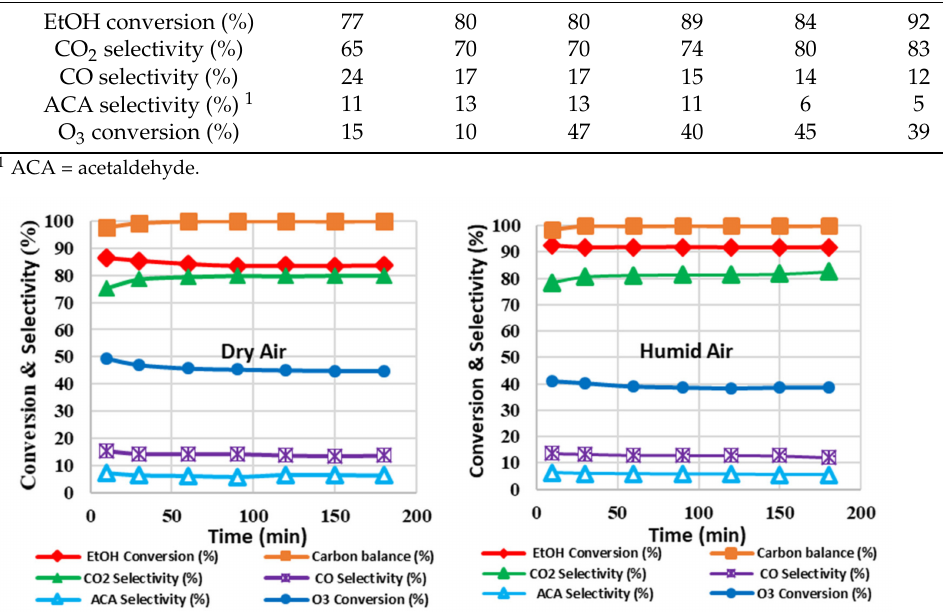
Figure 9. Ethanol conversion, ozone conversion, product selectivity and carbon balance as a func- tion of time on stream in dry ( left ) and humid ( right ) conditions (total flow rate = 500 mL · min − 1 , [EtOH] = 10 ppm, [O 3 ] = 70 ppm, T = 60 ◦ C) for the palladium-doped partially plugged monolithic catalyst (FM) with 16 channels (0.5Pd–5Mn–Ti/ PM